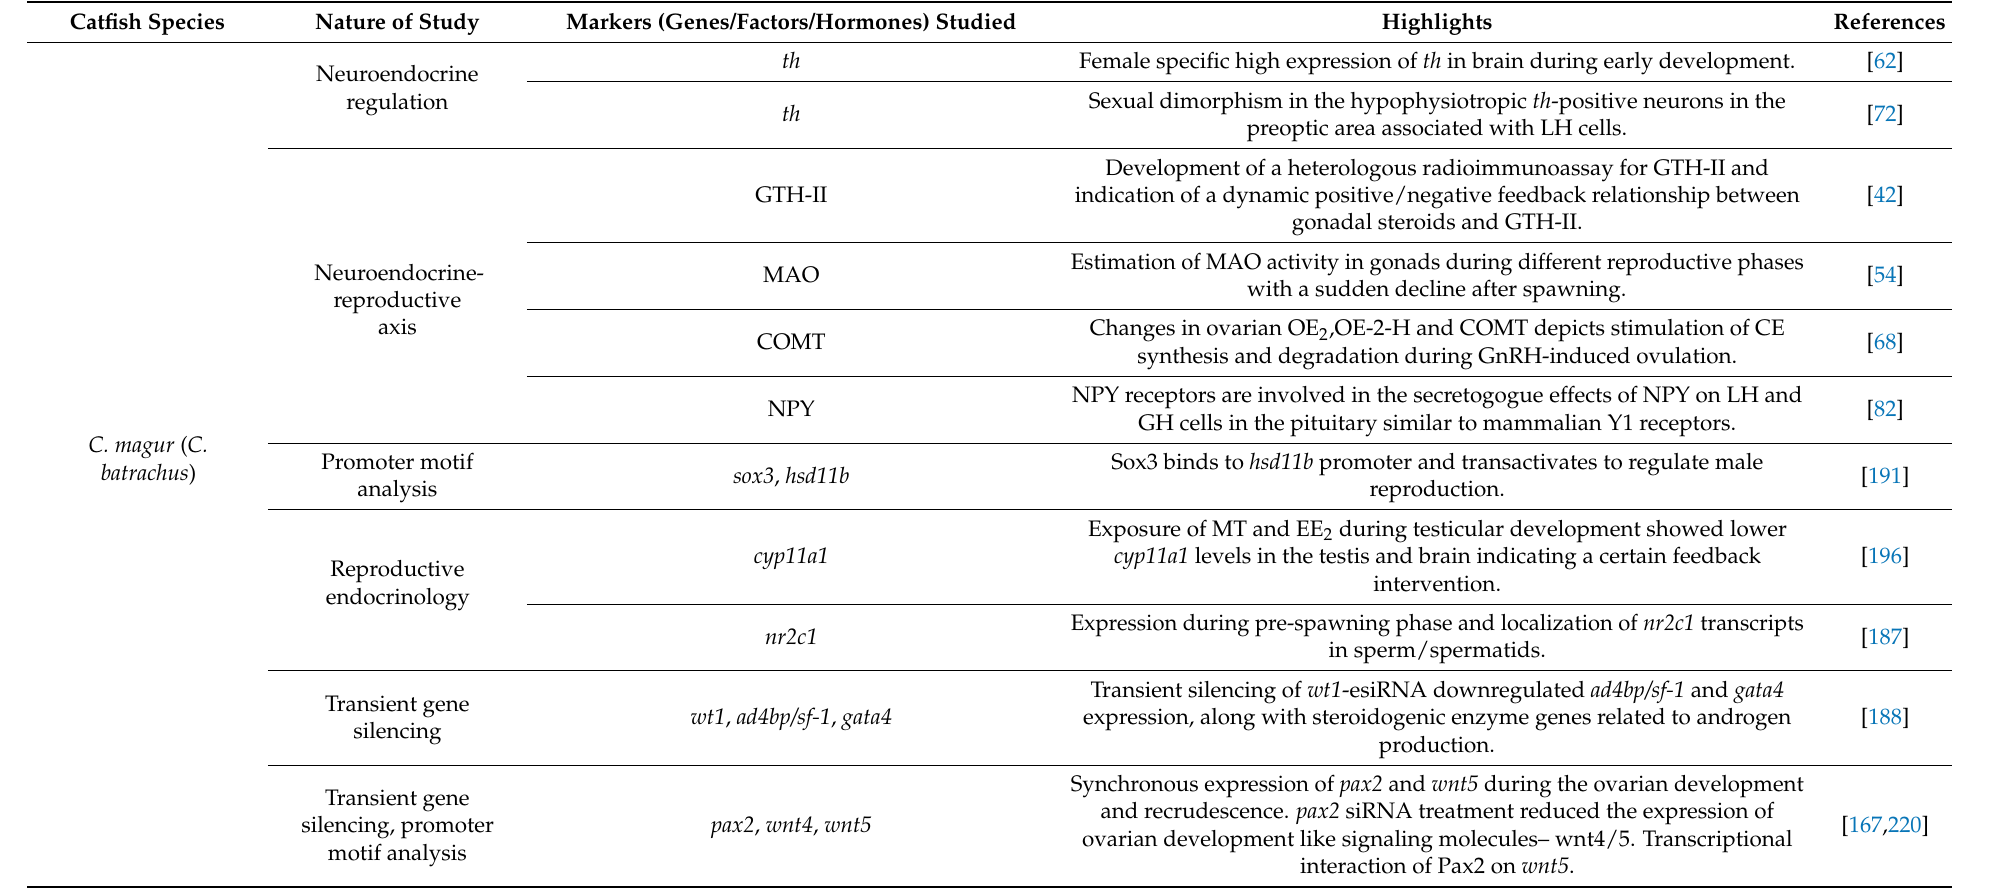
Table 1. Studies in catfish species: Identification of crucial genes/factors in reproduction and its neuroendocrine regulation. Catfish Species